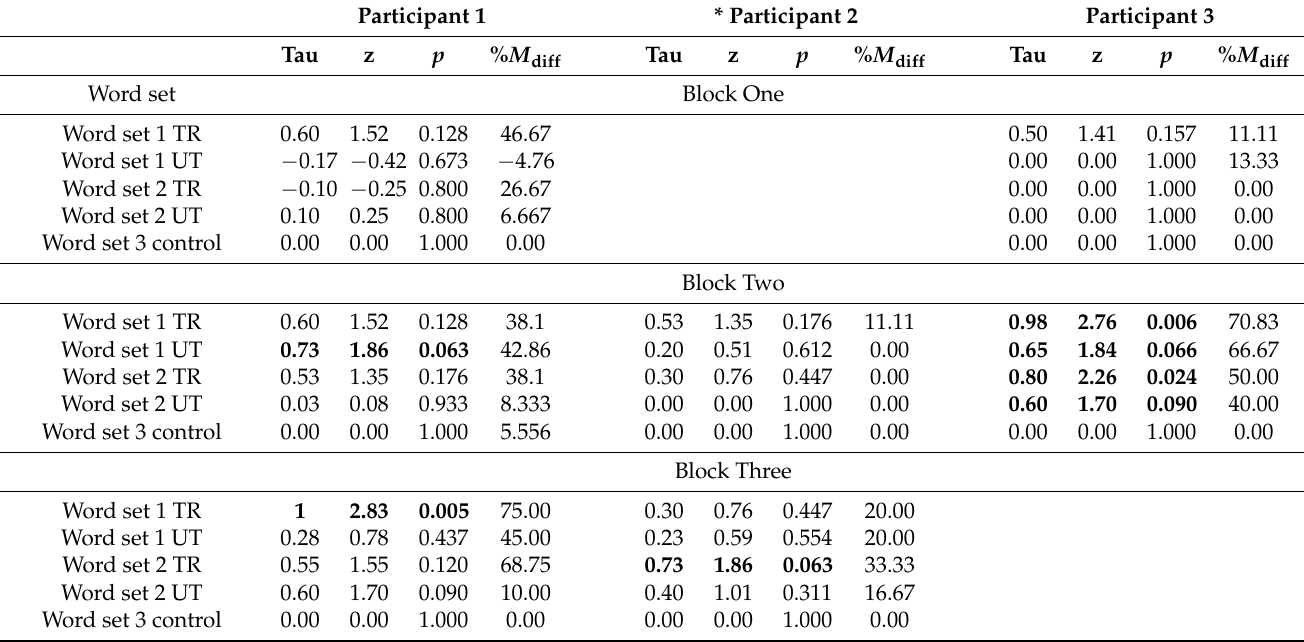
Table 6. Tau coefficient, z, p values, and pre to post mean difference in percent for each word sets for motor-speech movement patterns, scored across the Intervention